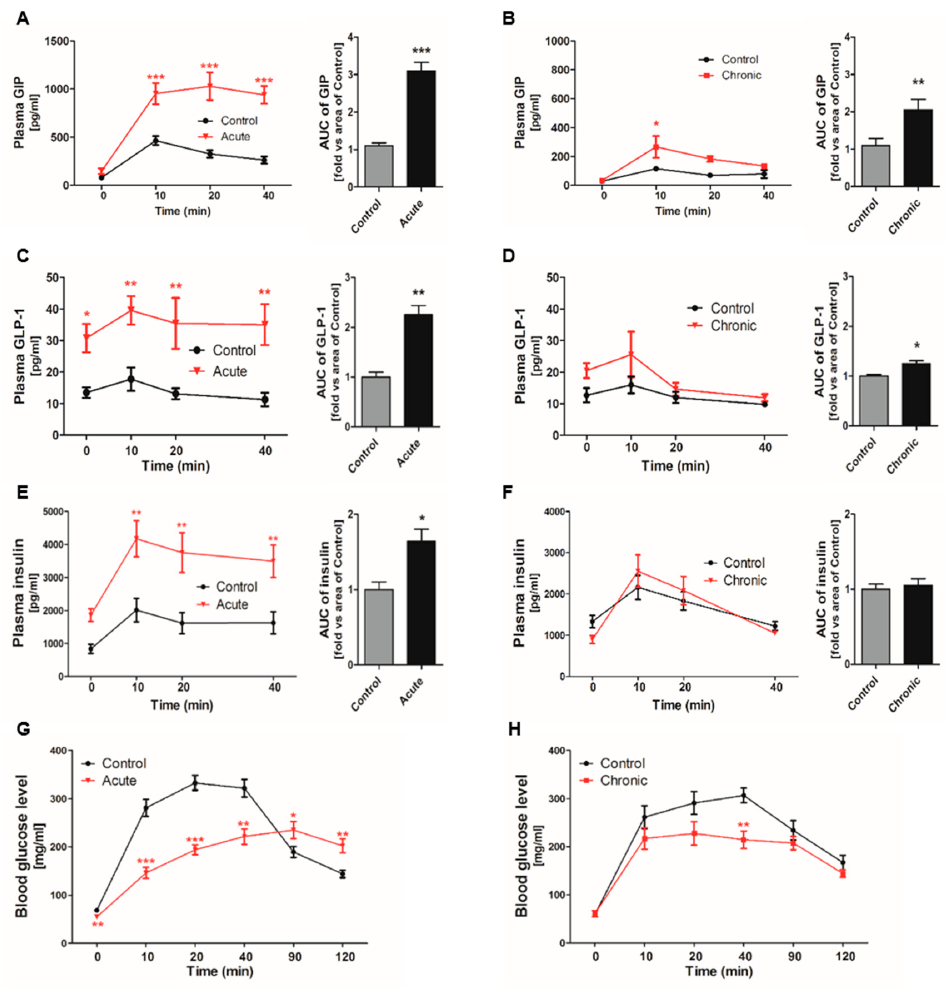
Figure 1. Incretin secretion increased by glucose gavage in gastrointestinal (GI)-inflamed mice. The hormone levels were measured at each time point. Total GIP secretion in response to oral glucose gavage (5 mg/kg) in the acute ( A ) and the chronic GI-inflamed group ( B ). Glucose-induced GLP-1 secretion in the acute ( C ) and chronic inflamed groups ( D ). Insulin secretion in the acute ( E ) and chronic inflamed groups ( F ). The plasma glucose concentrations were measured by OGTT under starvation conditions in the acute ( G ) and chronic groups ( H ). Black line: Control, red line: GI-inflamed mice, n = 5/group, * p < 0.05, ** p < 0.01, *** p < 0.001, one-way ANOVA. Grey bar: Control; black bar: GI-inflamed mice groups. * p < 0.05, ** p < 0.01, *** p < 0.001, Student’s t -test.